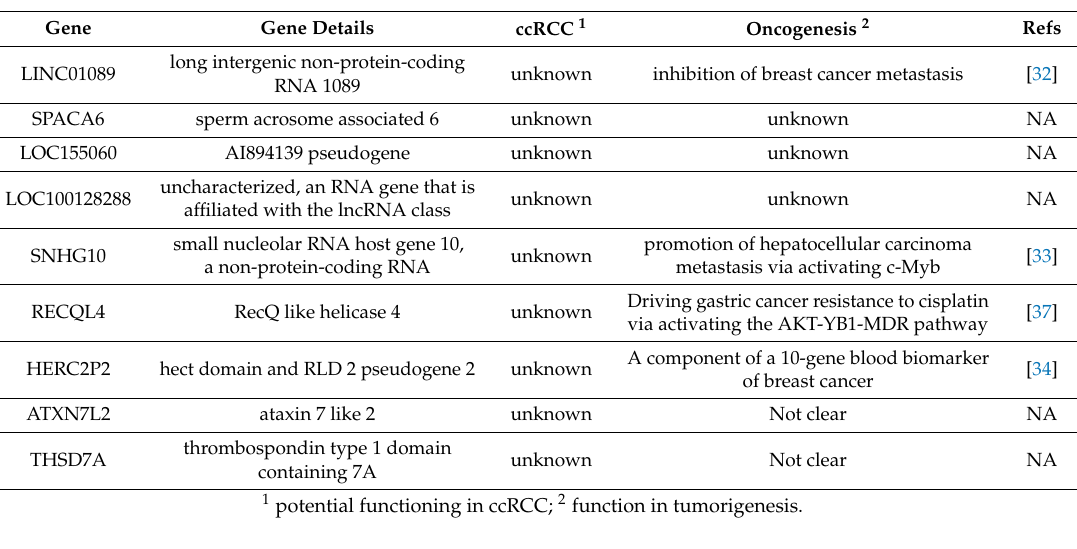
Table 5. Oncogenic functions of SigIQGAP1NW component genes.